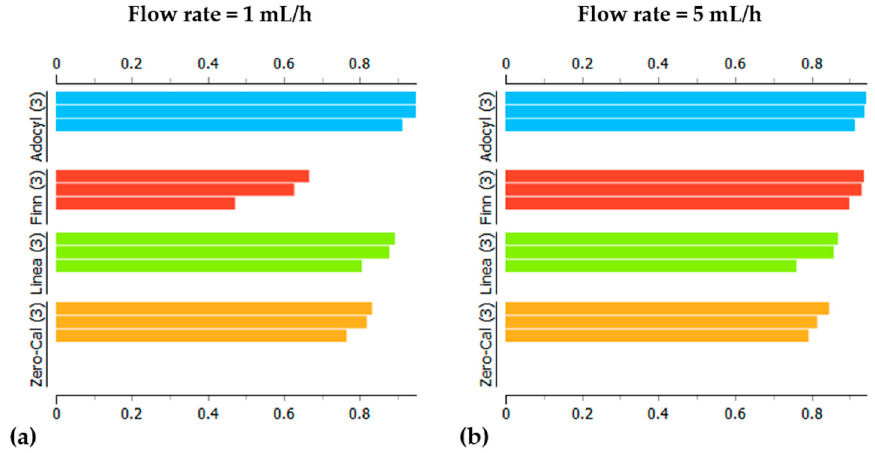
Figure 9. Silhouette plots of the sucralose-based sweeteners data obtained at ( a ) 1 mL / h and ( b ) 5 mL / h flow rates in a microfluidic e-tongue.